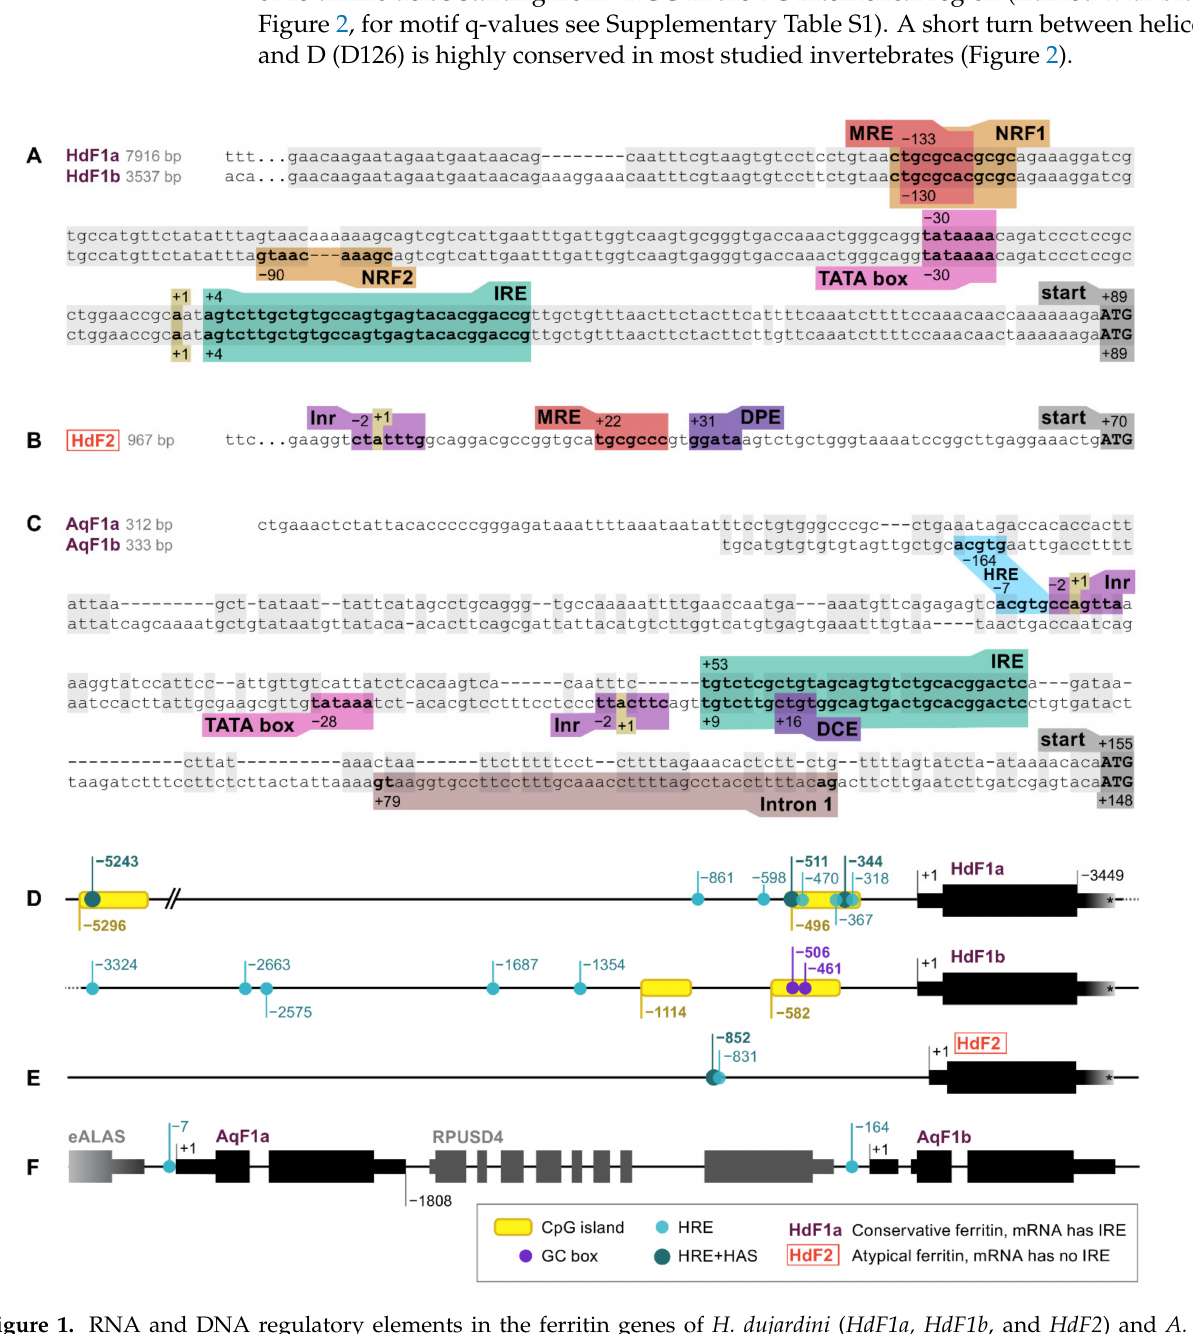
Figure 1. RNA and DNA regulatory elements in the ferritin genes of H. dujardini ( HdF1a, HdF1b , and HdF2 ) and A. queenslandica ( AqF1a and AqF1b ). ( A – C ) 5 (cid:48) sequences of sponge ferritin genes. ( D – F ) Arrangement of sponge ferritin gene copies, CpG islands, Hypoxia response elements (HRE) and Hypoxia ancillary sequences (HAS). 3 (cid:48) UTR lengths of H. dujardini ferritins are only shown schematically since unlike the 5 (cid:48) UTRs they have not been experimentally confirmed; the assembled transcripts are longer than depicted in the figure (Supplementary Table S1). MRE, metal regulatory element; IRE, iron-responsive element; Inr, initiator of transcription; DPE, downstream promotor element; DCE, downstream core element. See Supplementary Table S2 for motif sequences and other